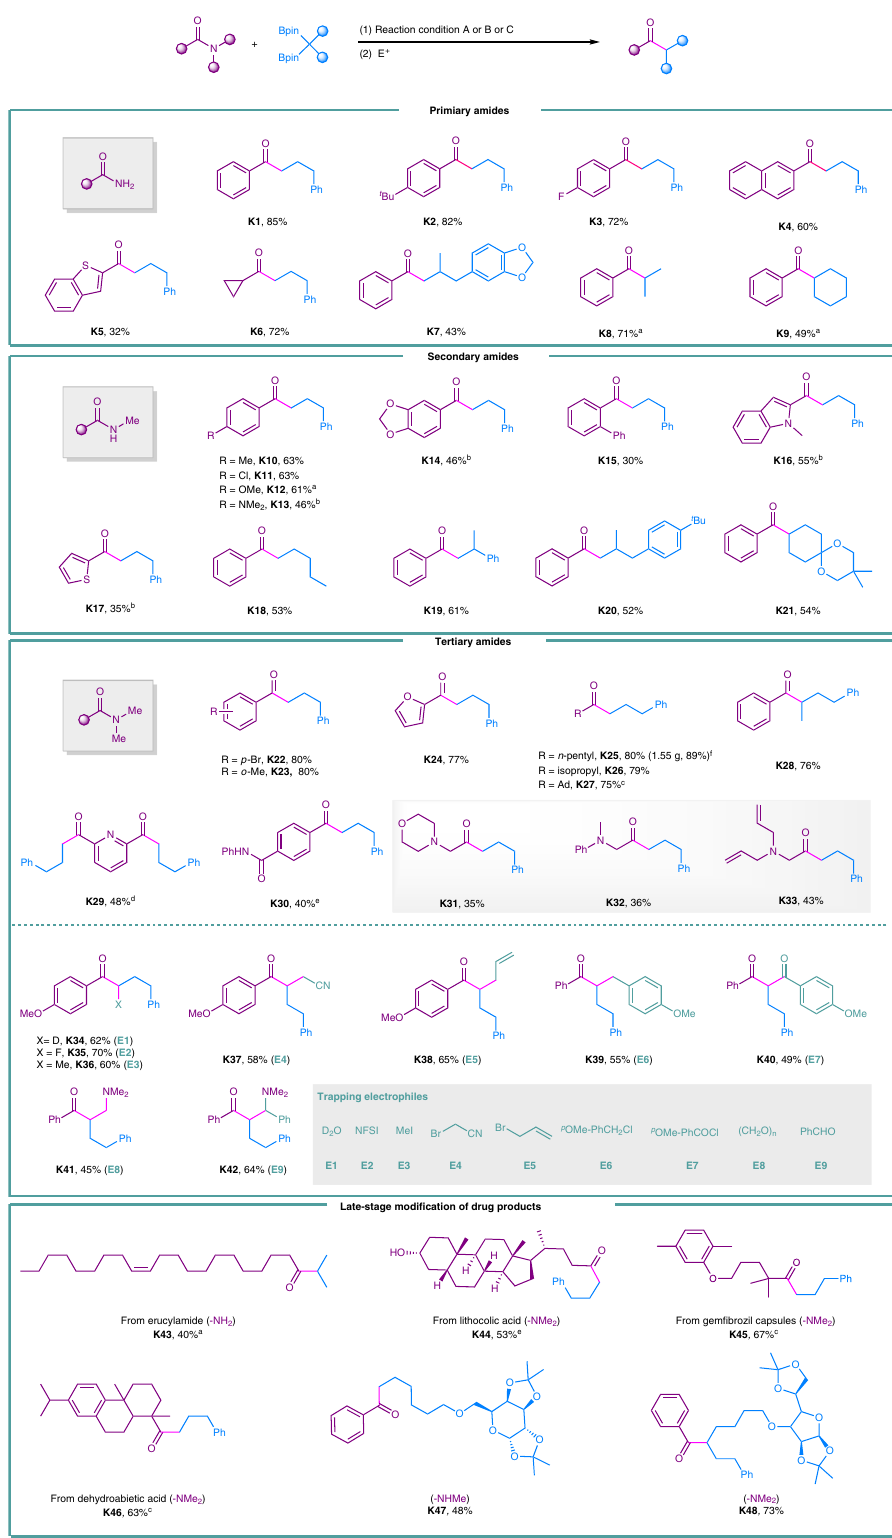
Fig. 4 Exploration of substrate scope for the synthesis of ketones from amides. Reaction condition A for primary amide: 1 (0.50 mmol), primiary amide P (0.25 mmol), n BuLi (1.0 mmol), THF (2.0 mL), 0 °C, 5 min then 100 °C for 12 h; Reaction condition B for secondary amide: 1 (0.50 mmol), secondary amide S (0.25 mmol), n BuLi (0.75 mmol), Al(OEt) 3 (0.375 mmol), THF (2.0 mL), 0 °C, 5 min then 100 °C for 4 h. Reaction condition C for tertiary amide: 1 (0.375 mmol), tertiary amide T (0.25 mmol), MeLi (0.375 mmol), anisole (2.0 mL), 0 °C, 5 min then 120 °C for 2 h. For detailed conditions of trapping electrophiles, see Supplementary Information. Yields based on isolated products. a 24 h. b 12 h. c THF was used instead of anisole. d 1 (0.75 mmol), MeLi (0.75 mmol). e MeLi (0.625 mmol). f 8.0 mmol scale. Ad: